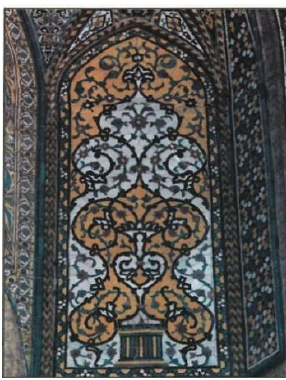
Figure 3. Sepahsalar Mosque, Tehran, Dibaj, 2009